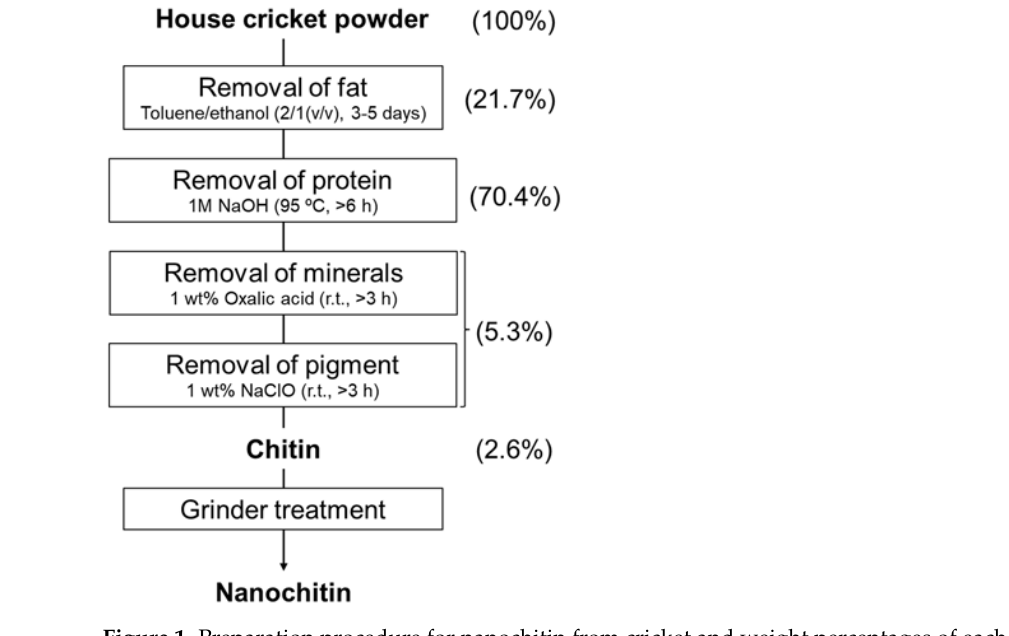
Figure 1. Preparation procedure for nanochitin from cricket and weight percentages of each ex ‐ tract.